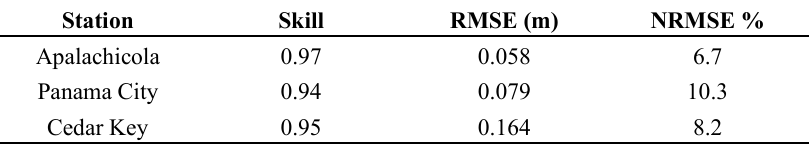
Table 3. Quantitative assessment of harmonic resynthesis